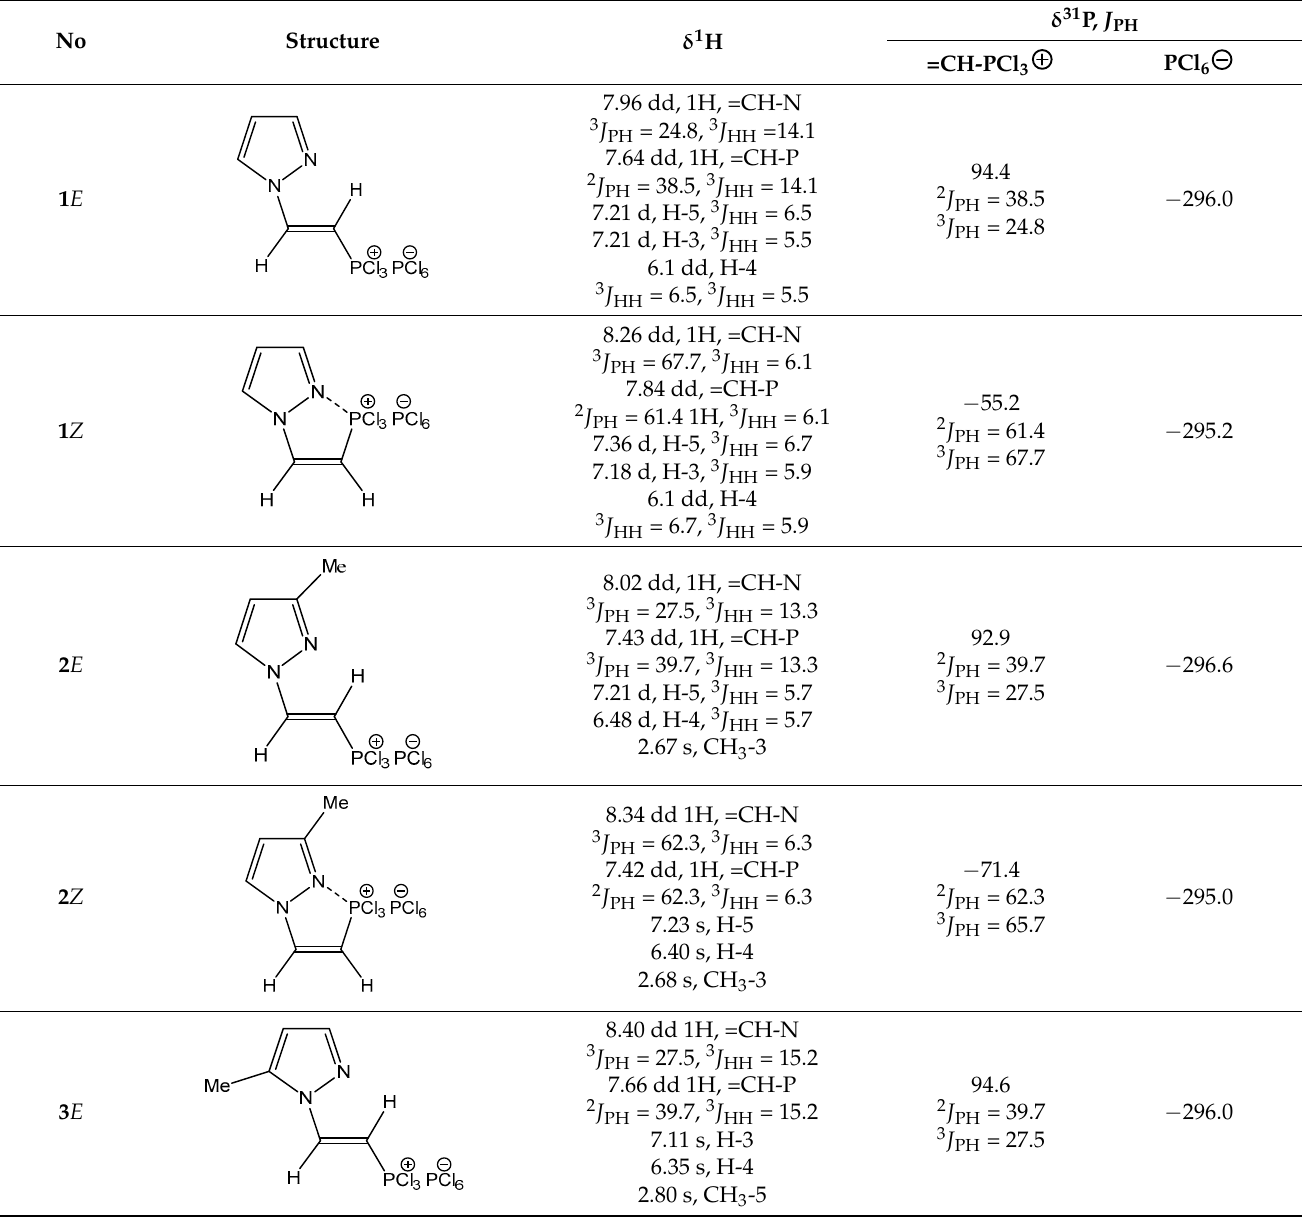
Table 2. The 1 H and 31 P NMR chemical shifts ( δ , ppm) and coupling constants ( J , Hz) of hexa- chlorophosphorates 1 – 4 , 9 , 11 , 13 , 18 .